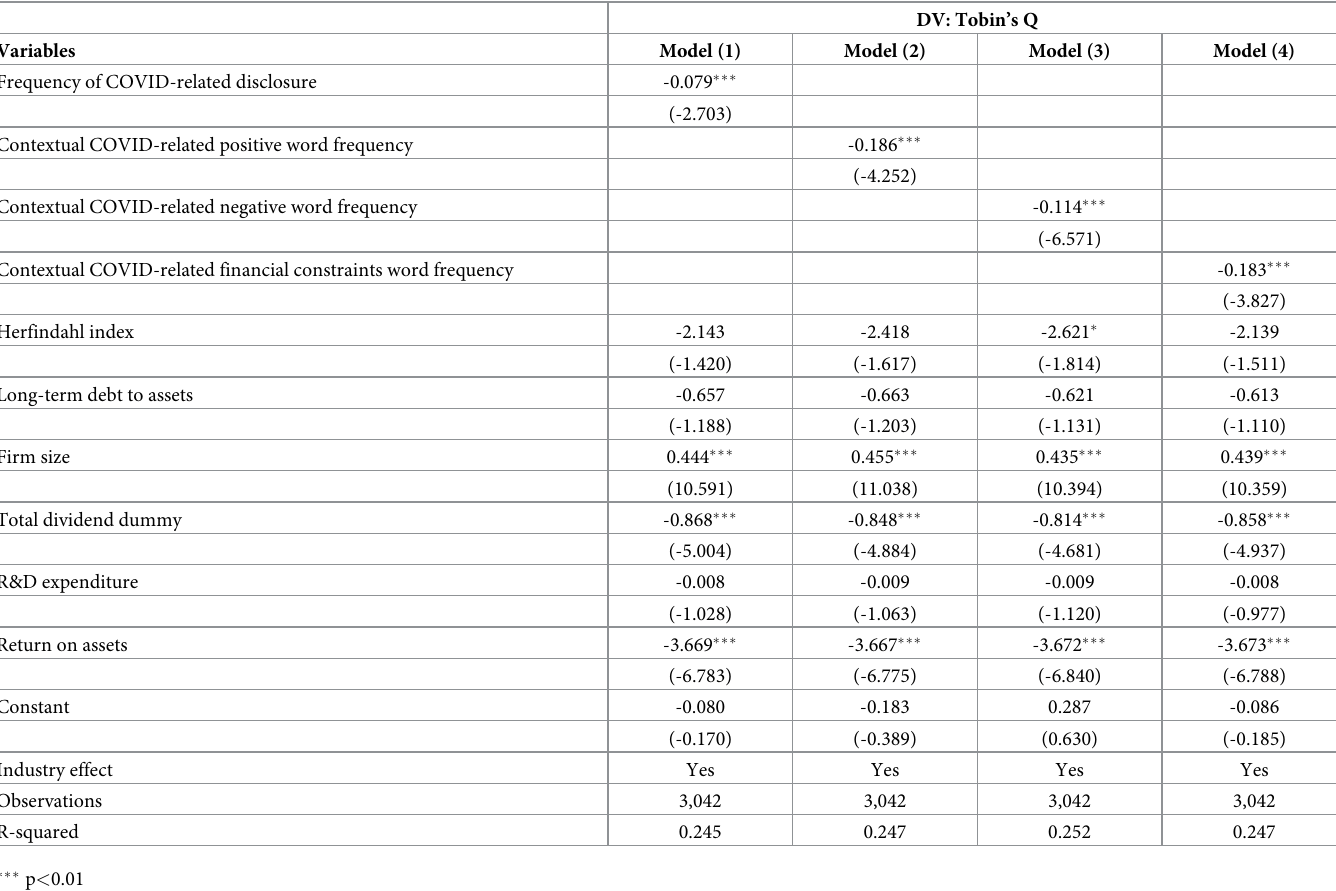
Table 11. Relationship between COVID-related disclosure and Tobin’s